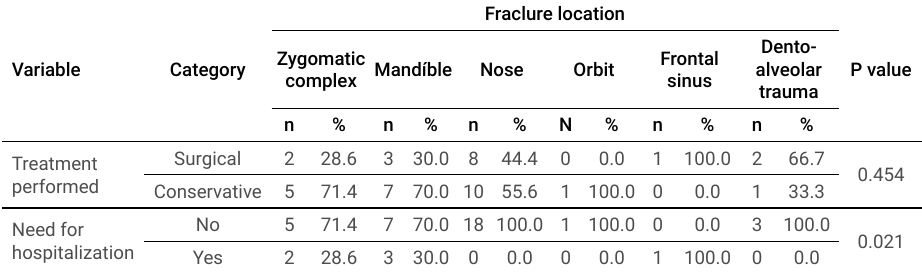
Table 4 . Distribution of patients by treatment performed and the need for hospitalization according to fracture location and likelihood ratio test significance.